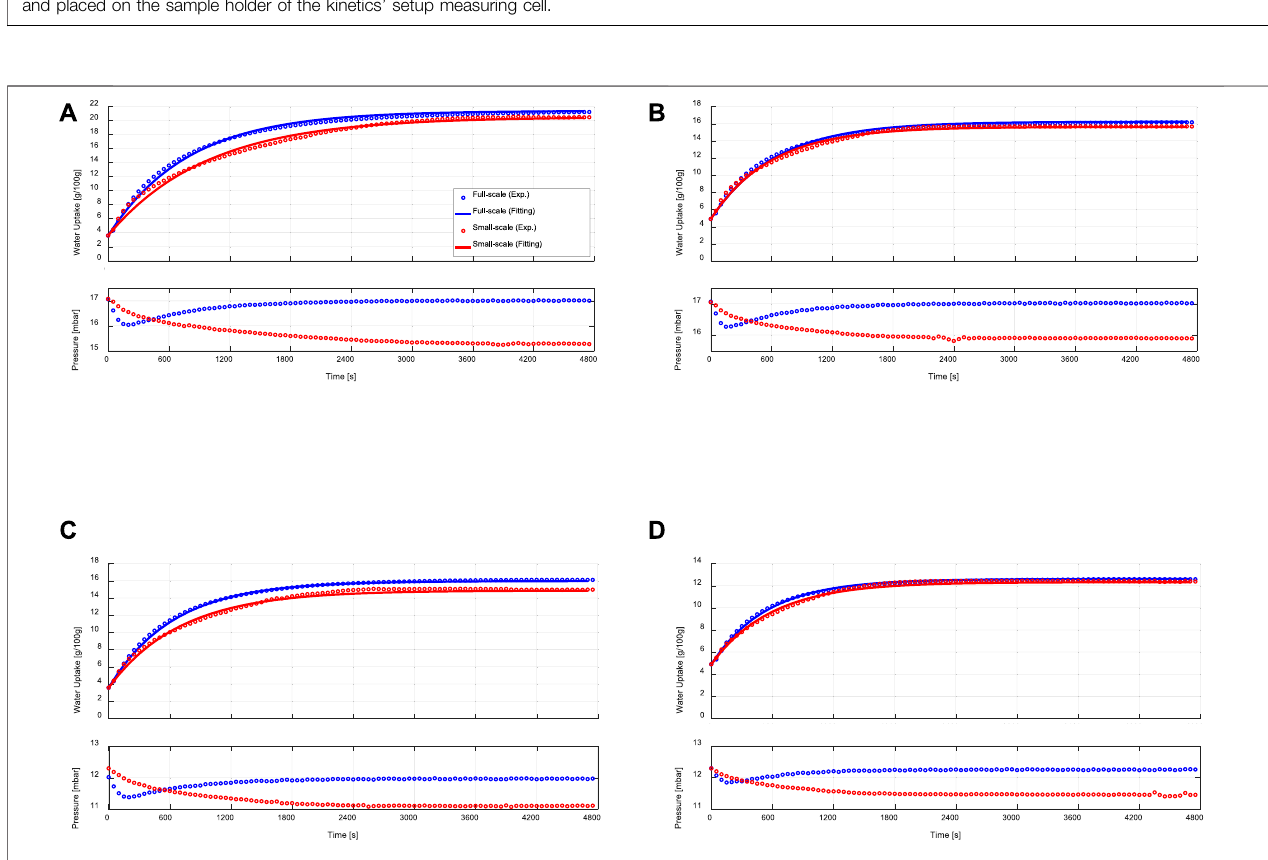
Frontiers in Energy Research |